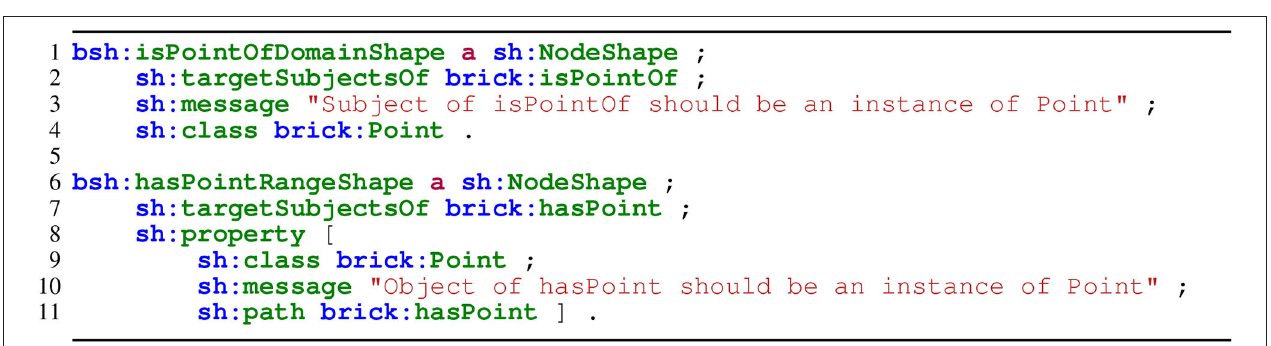
FIGURE 9 | An example of a logical violation in an instance of a Brick+ model.